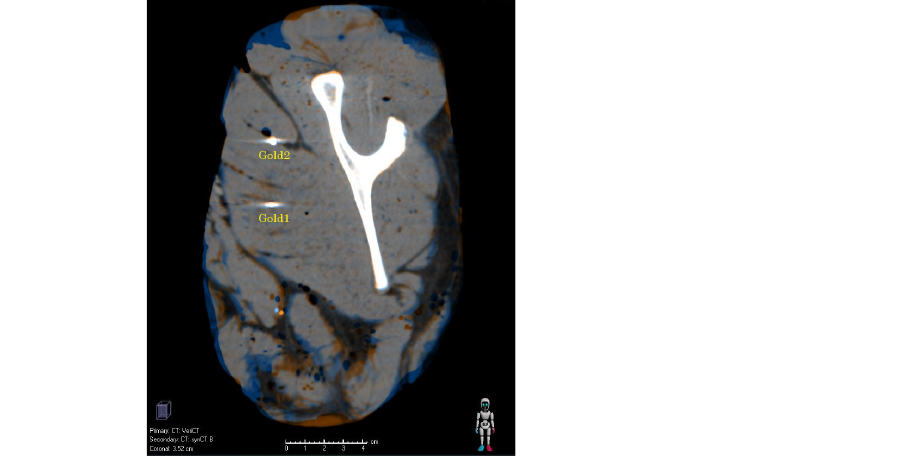
Figure 2. Validation images (coronary view) based on the porcine phantom. The orange (blue) intensity indicates that the CT value of the synthetic CT (verification CT) is bigger.